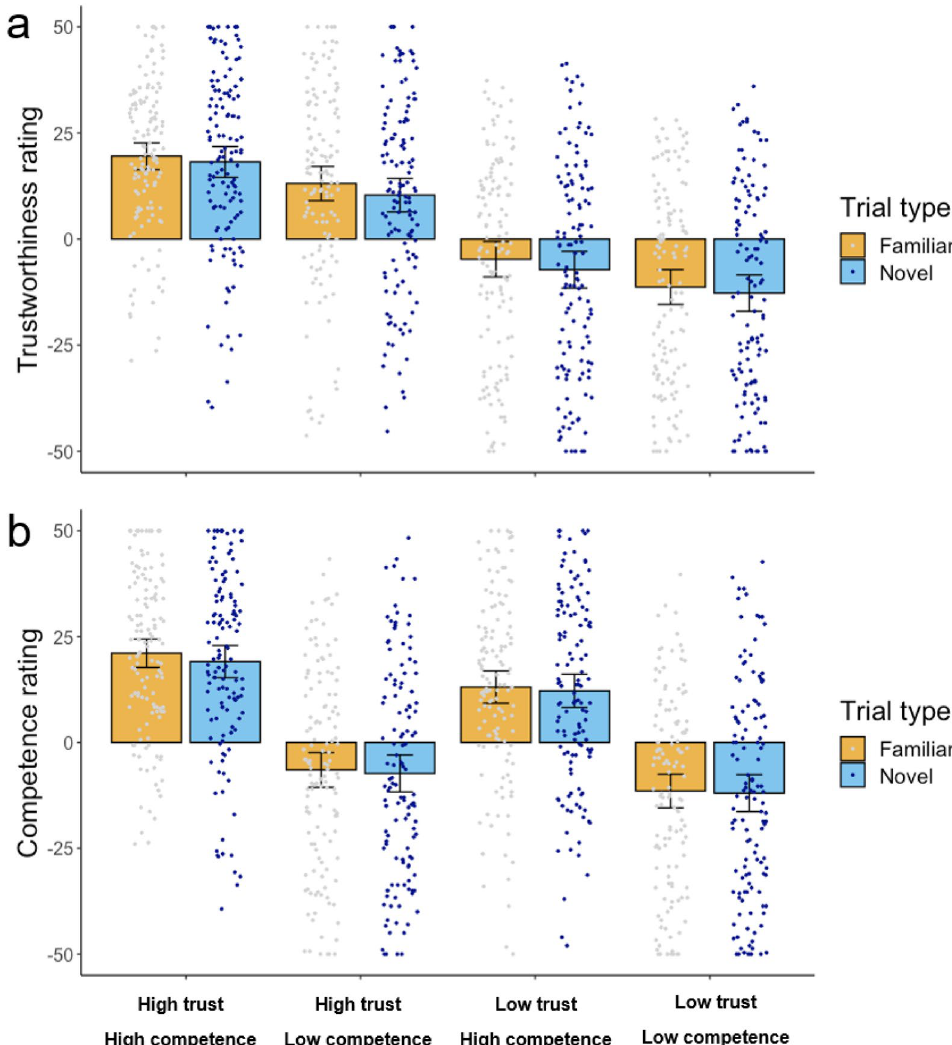
Figure 3. ( a ) Results from Experiment 3, judgements of trustworthiness. ( b ) Results from Experiment 3, judgements of competence. Error bars represent 95% confidence intervals around the